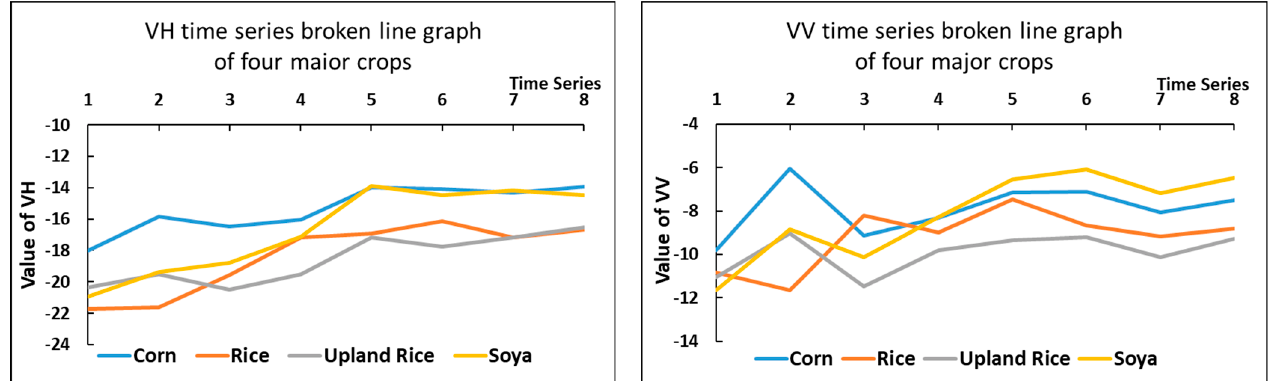
Figure 5. Time series broken line statistics of microwave features. Two images of similar time were averaged to form a new image. They were placed on the x -axis in the order of 1–8.